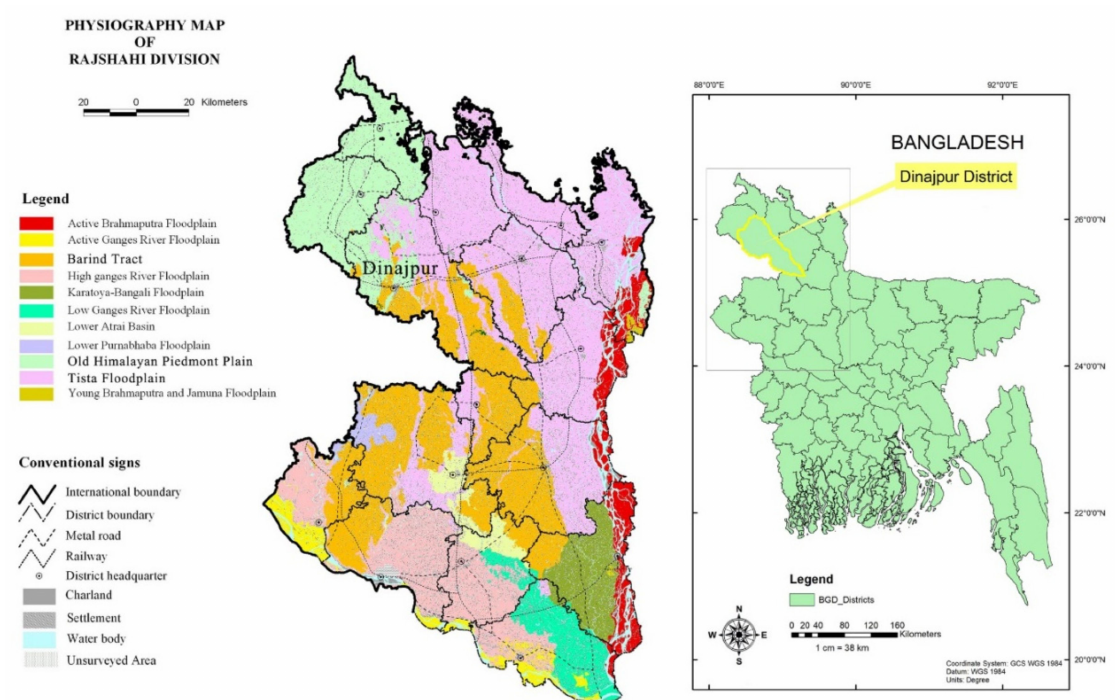
Figure 1. Location and soil physiography of Dinajpur, Northwestern Bangladesh, with those physiographic types examined bolded in the